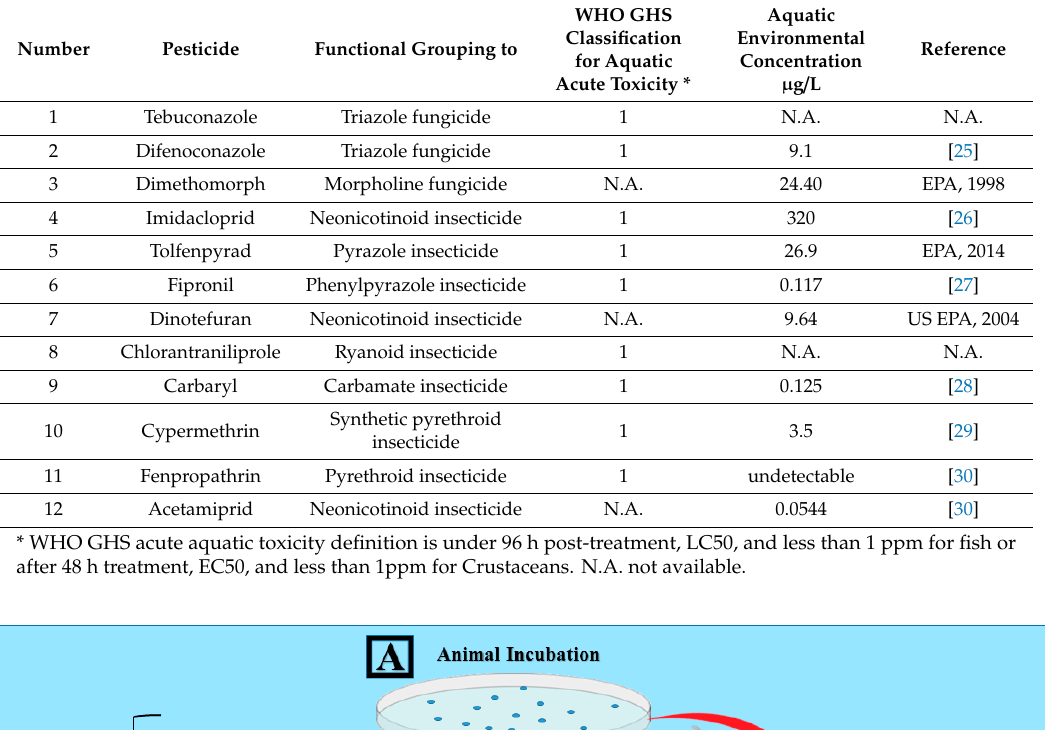
Table 1. Information for the twelve pesticides used to perform locomotor activity assay in both zebrafish and daphnia studies.